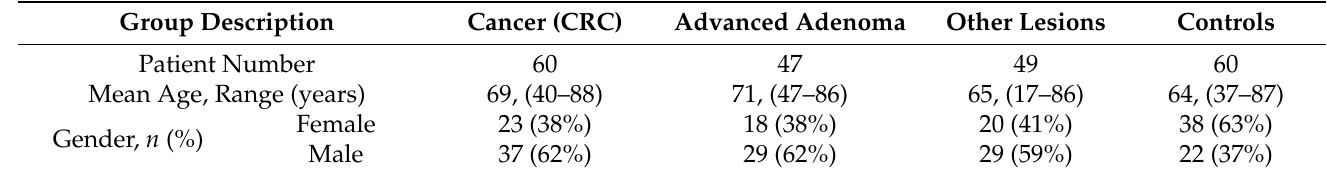
Table 1. Clinical Data from Patients and